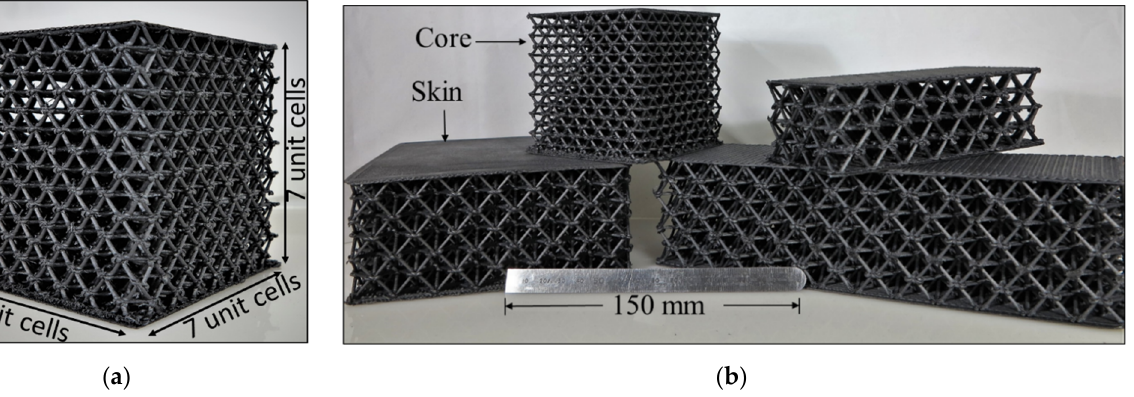
Figure 13. ( a ) Lattice block used for compression testing with 7 unit cells repeated in the X, Y, Z directions. ( b ) The ALE process used to fabricate lattice block in different unit cell configurations and shapes.